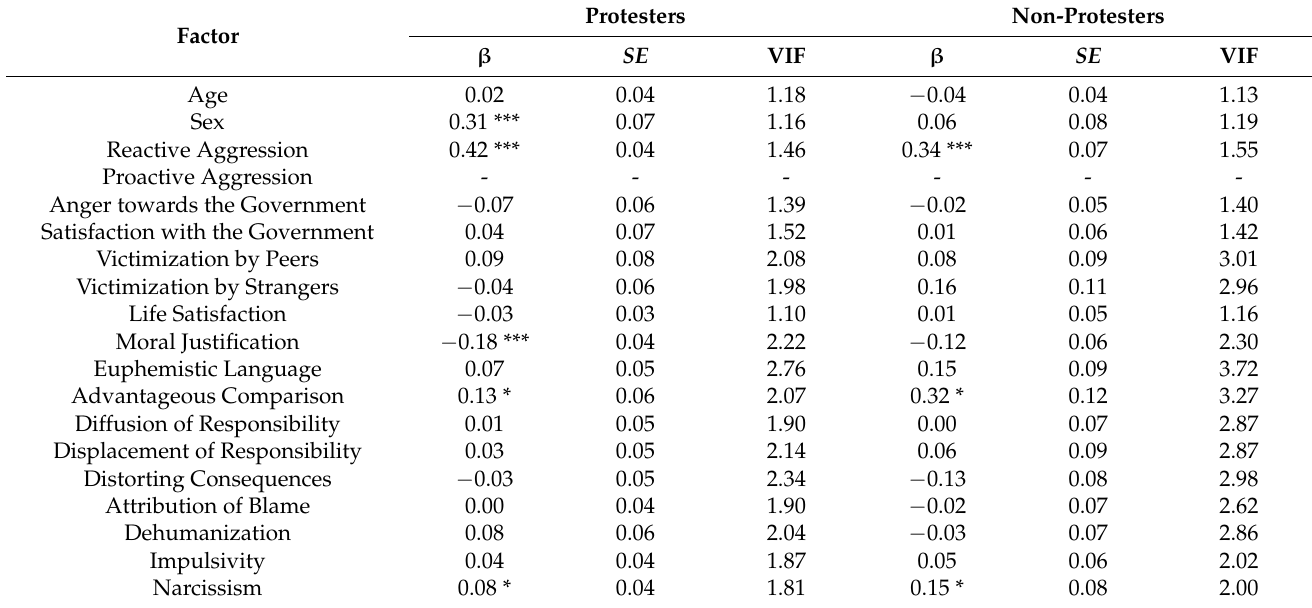
Table 9. Unconstrainted Model Predicting Proactive